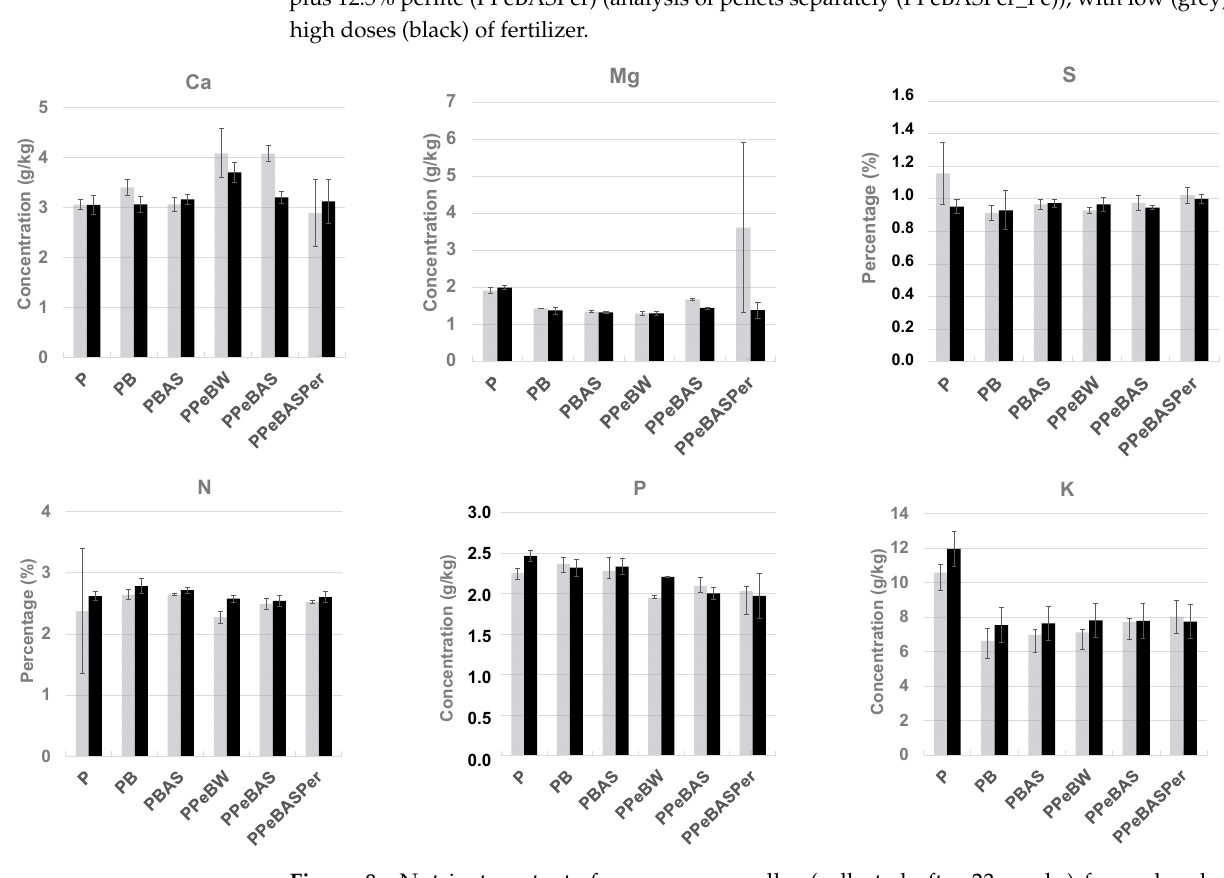
Figure 8. Nutrient contents from spruce needles (collected after 23 weeks) for each substrate: 100%